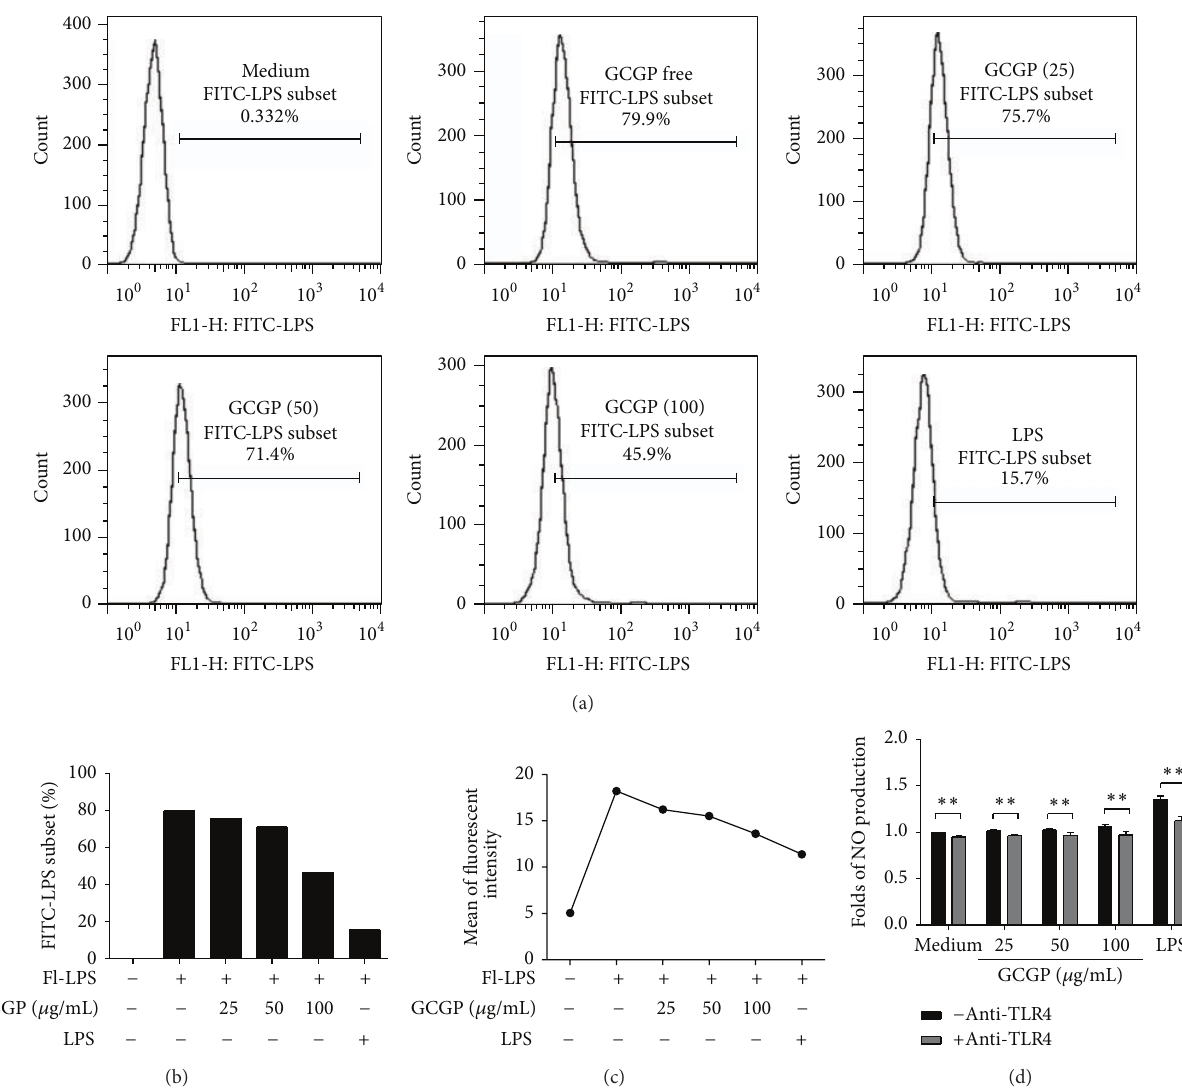
Figure 4: Effect of GCGP competitively binding RAW264.7 cells with FITC-LPS ((a) and (b)). Percent of positive FITC-LPS (FITC-LPS subset). (c) Mean of fluorescent intensity. Cells were incubated with 5 𝜇 g/mL FITC-LPS and unlabeled GCGP (25, 50, and 100 𝜇 g/mL) or unlabeled LPS (5 𝜇 g/mL) together for 1h at 4 ∘ C and then examined by flow cytometric analysis. (d) Anti-mouse TLR4 attenuated NO production induced by GCGP in RAW264.7 cells. Cells were pretreated with anti-TLR4 (20 𝜇 g/mL) or medium for 2 h before the addition of GCGP. After 24 h incubation, NO production was analyzed as described in Materials and Methods. Results correspond to the mean ± SD of three independent experiments. ∗∗ 𝑃 < 0.01